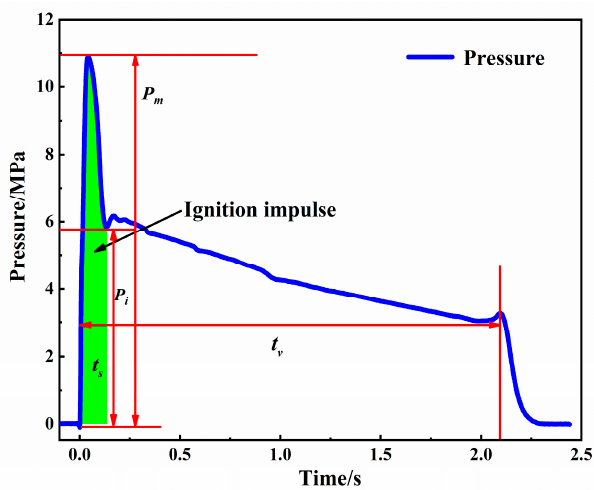
Figure 3. P - t curve of pyrotechnic igniter and characteristic parameter.